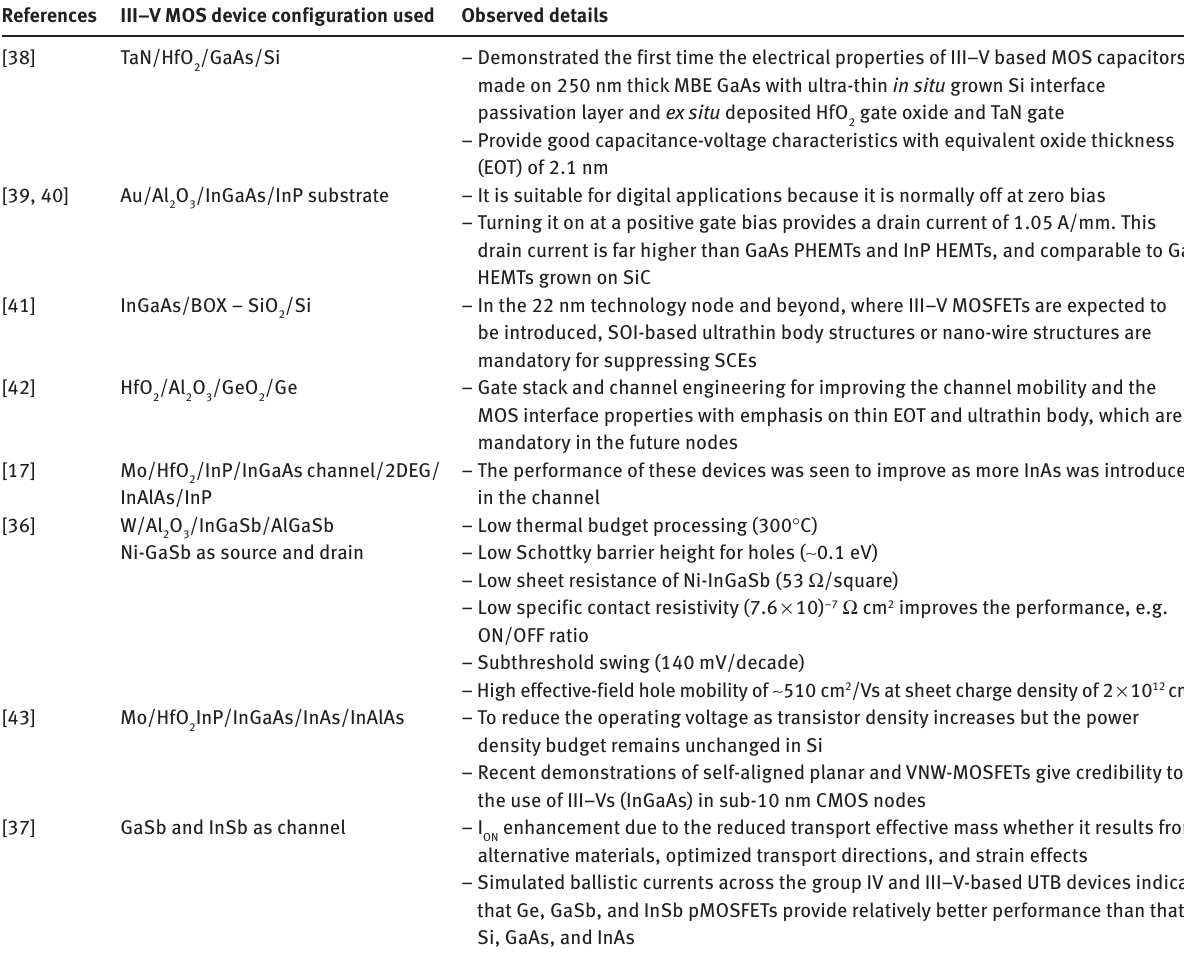
Table 1: Literature reported on III–V MOS devices. References III–V MOS device configuration